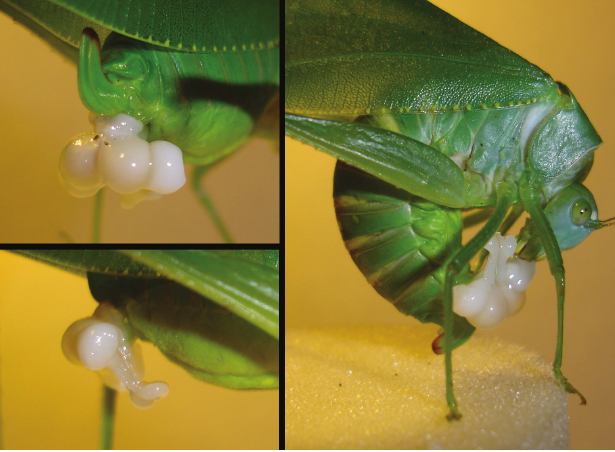
Fig. 8. Female with spermatophore after